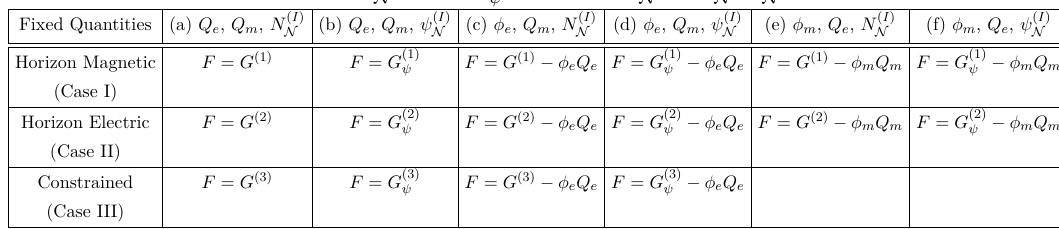
Figure 2 . Noether Charge Entropy for Case 3. Left: two plots of the Noether charge entropy S N in case 3, for ‘ = 12 , as a function of ( n, r + ) . The lower (blue) plot is for e = 0 and the upper (yellow) one for e = 0 . 6 . The grey plane indicates zero. Right: a plot of S N (blue) and S + (red) as a function of M for ‘ = 7 , e = . 13 , and n = 1 . 5 . Table 1 . Free Energy and Phase Behaviour for Various Ensembles at fixed pressure